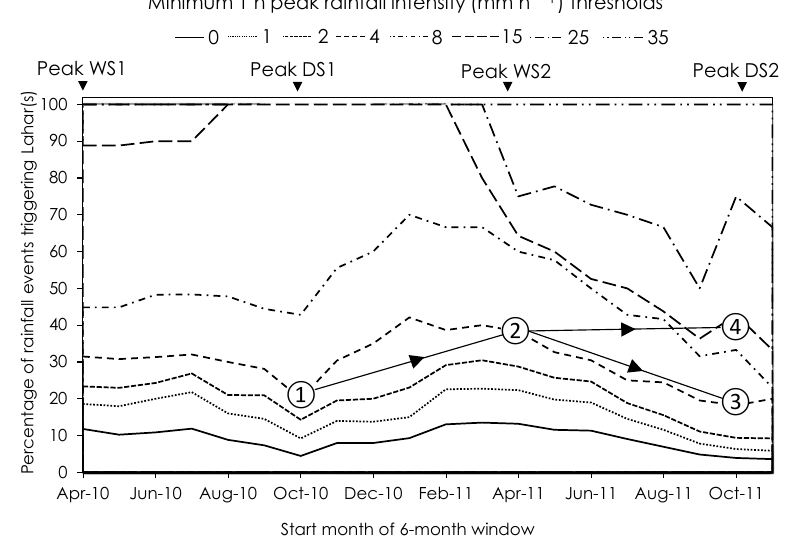
Figure 6. Seasonal and temporal effects on lahar probability. Contour graph of empirically derived lahar probability relative to the exceedance of 1h peak rainfall intensity (1hPRI) thresholds in 6-month moving data windows with 1-month staggered start dates. White numbers and dashed lines show temporal trends. Following the empirically derived 4mmh − 1 PRI contour, there is a 20% probability of a lahar if this threshold is exceeded at “1” (6-month start date of 13 October 2010). This probability increases to 38% at “2” (13 April 2011) and declines to 18% at “3” (13 October 2011). Alternatively, reading horizontally across the graph for a lahar probability of 38%, the associated PRI threshold increases from 4mmh − 1 at “2” (13 April 2011) to approximately 15mmh − 1 at “4” (13 October